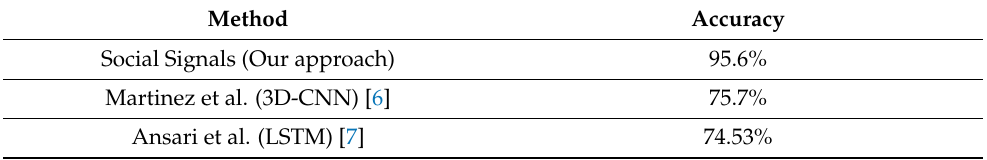
Table 24. Comparison with deep learning